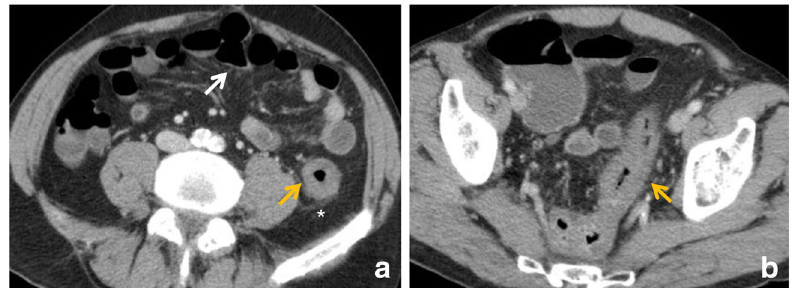
Fig. 3 Ischaemic colitis in a 74-year-old male with vasculitis who pre- sented with abdominal pain and bloody diarrhoea. ( a , b ) Contrast- enhanced CTscan reveals involvement of the sigmoid colon and splenic